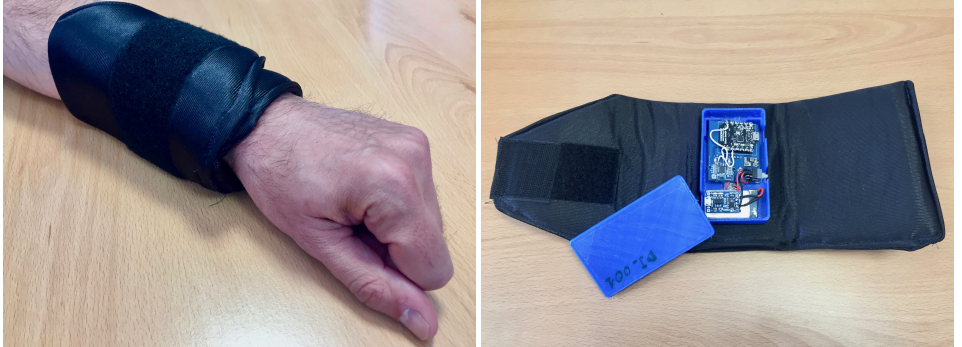
Figure 1. Bracelet prototype and its hardware